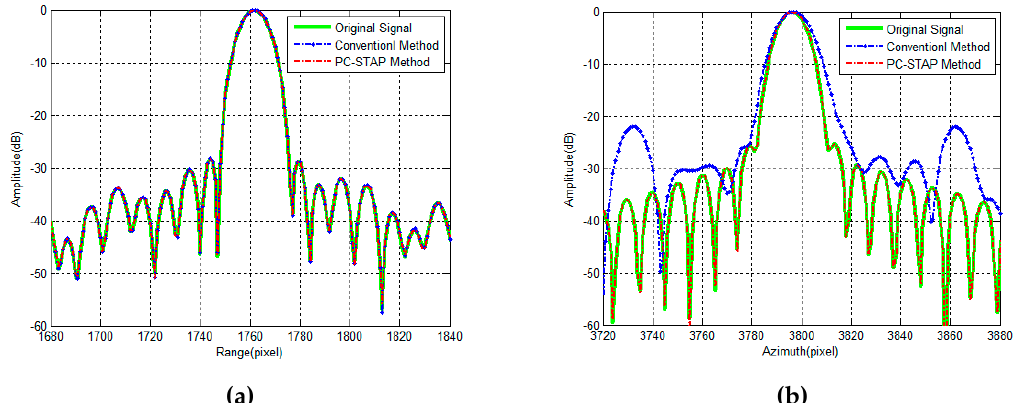
Figure 6. Comparison of point target profile (M = 16): ( a ) Range profile; ( b ) Azimuth